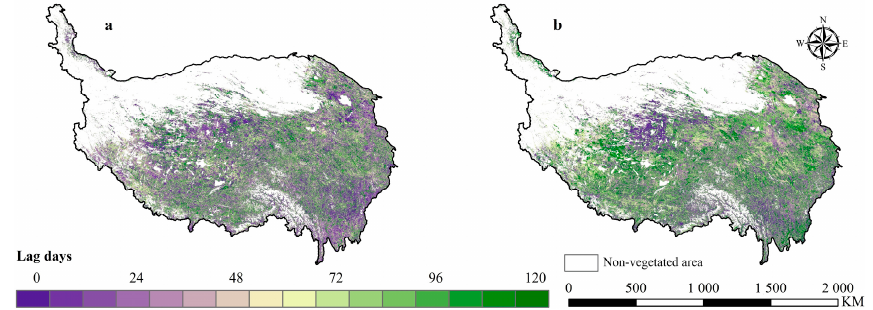
Figure 9. The spatial distribution of climatic factor’s time lag at which the maximum partial correlation coefficient between the GNDVI and ( a ) temperature and ( b ) moist coefficient on the QTP during 2000–2019.